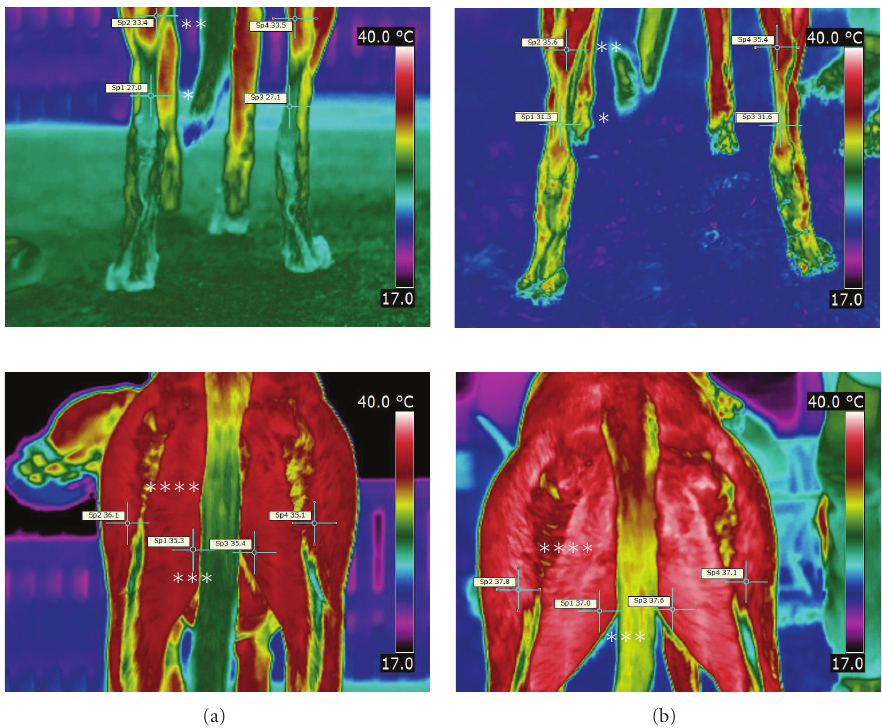
Figure 1: Thermographic images before (a) and after (b) the race, showing the four measurement points of the tendo calcaneus ( ∗ ), musculus gastrocnemius ( ∗∗ ), musculus gracilis ( ∗∗∗ ), and musculus biceps femoris portio caudalis ( ∗∗∗∗ ).